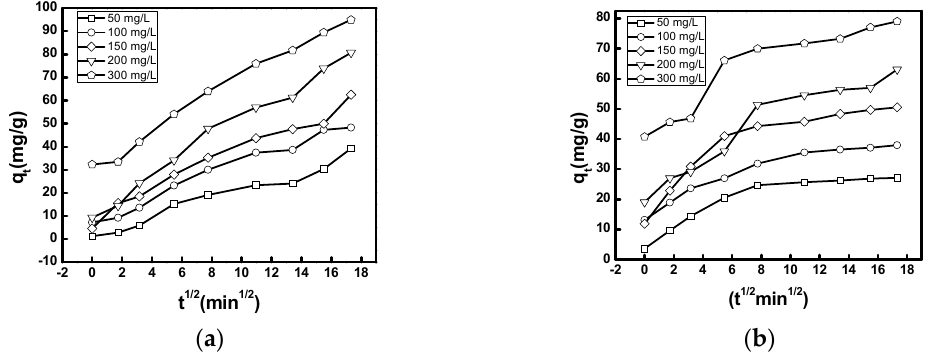
Figure 7. Adjusted intraparticle diffusion model for the adsorption of 2,4-D onto ( a ) AC and ( b ) MAC at different initial concentrations and 25 °C.